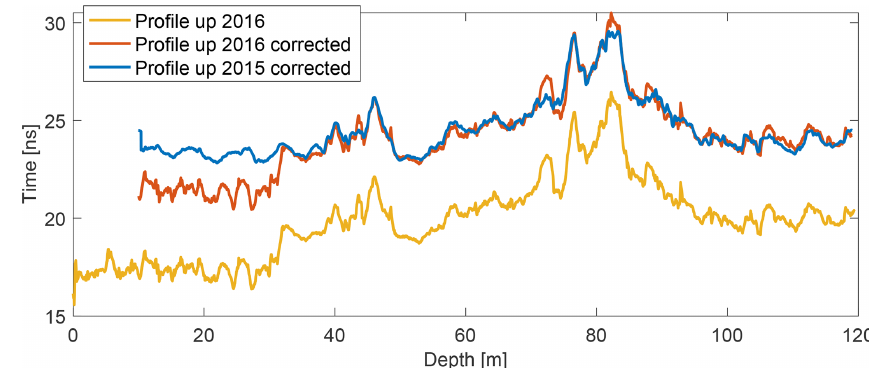
Figure A2. Comparison of zero-time corrected travel times of the 2015 and 2016 BHR data.